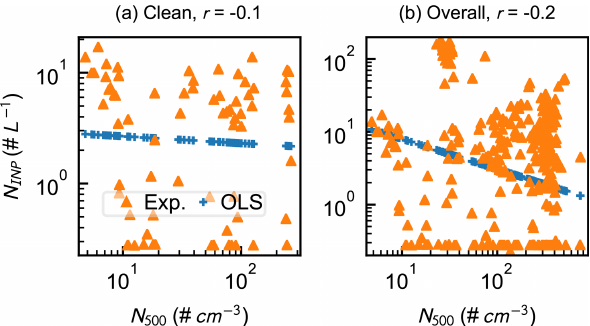
Figure C2. Correlations between N 500 and N INP for (a) clean days and (b) the observation. The r above each panel is Pearson’s correlation coefficient. Blue markers indicate the predicted N INP using fitted linear regression parameters.